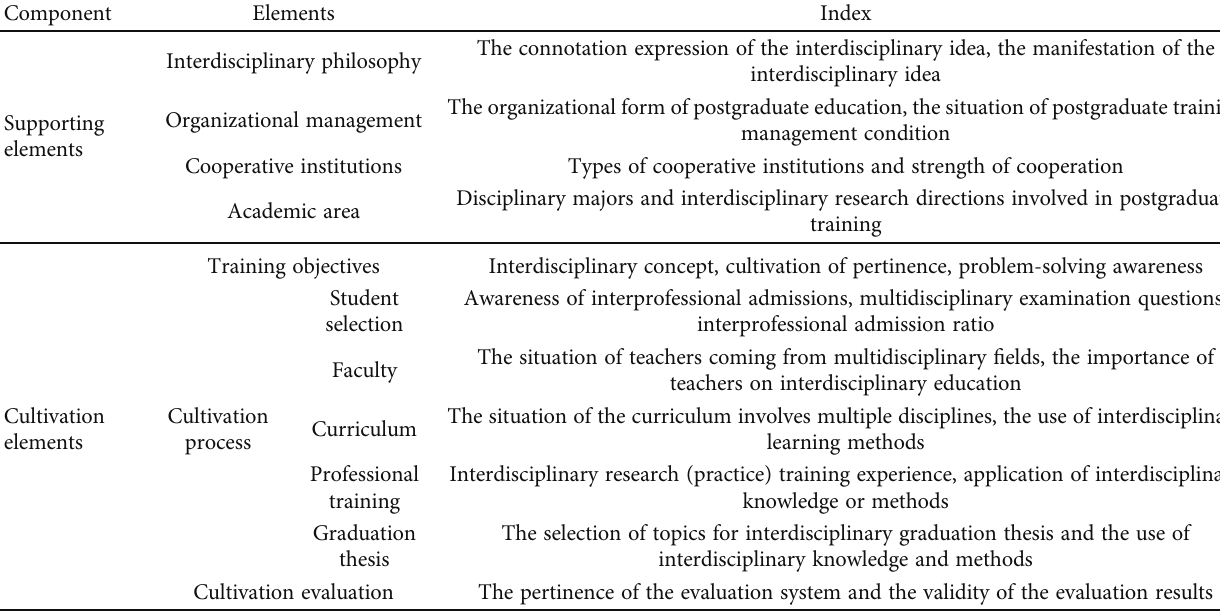
Table 2: Evaluation index system of interdisciplinary training mode.